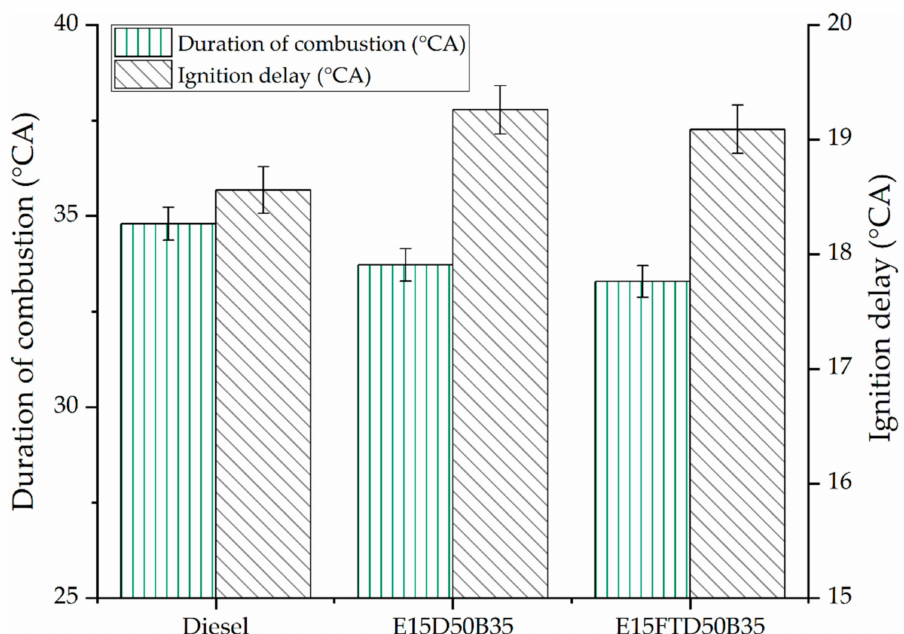
Figure 5. Duration of combustion and ignition delay for different fuels at 2 bar IMEP and 1500